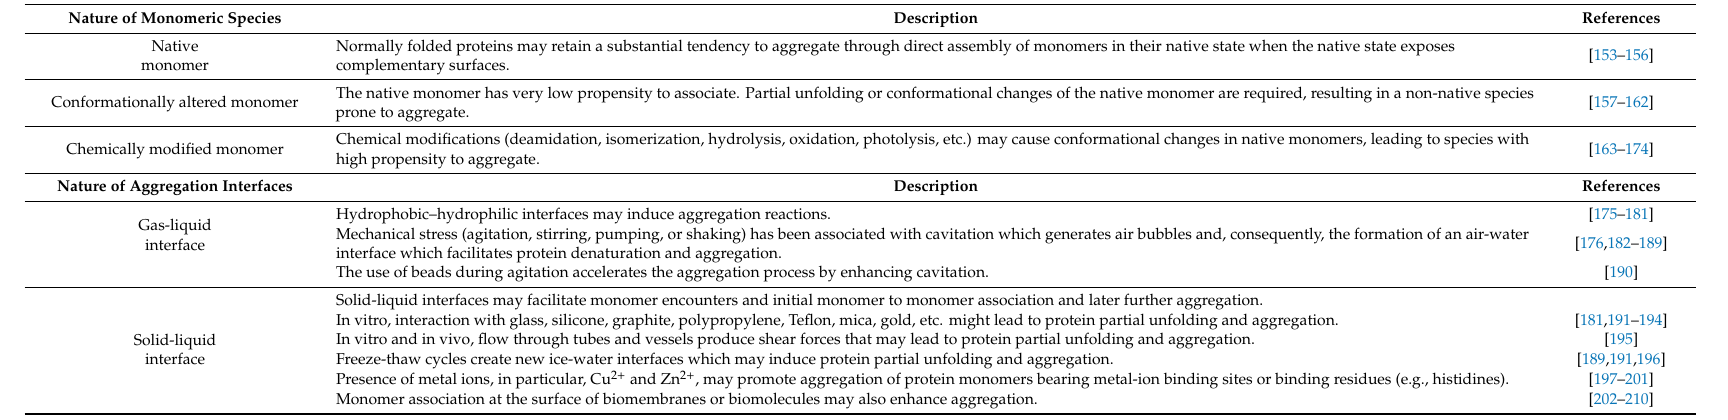
Table 4. Early events that may lead to amyloid fibril